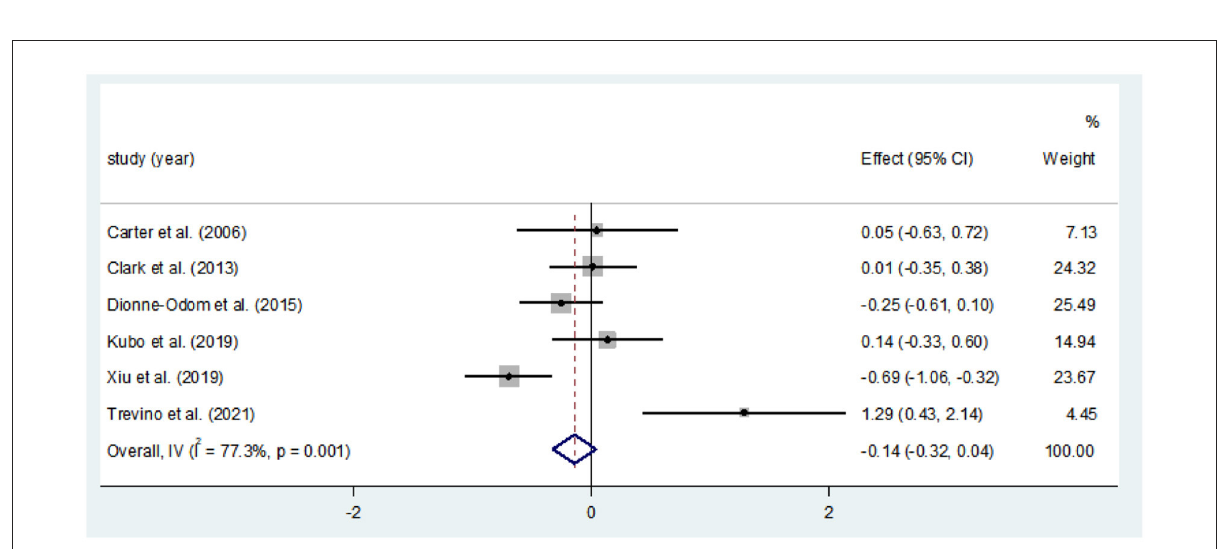
FIGURE5 Forest map for estimating the effect size of QOL in CQOL-C subgroup [excluding Han et al. (25)].